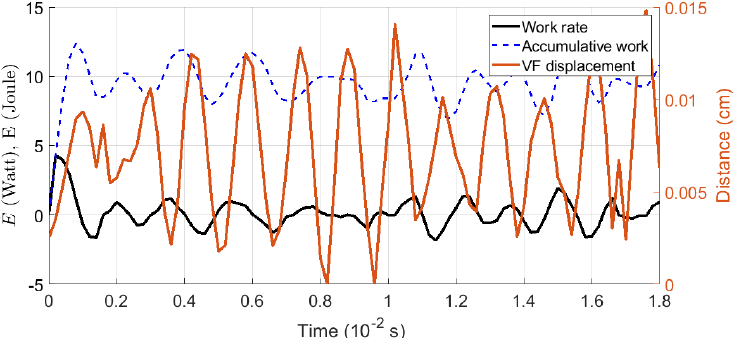
Figure 5. Rate of work, accumulative work, and VF vibration for Sample